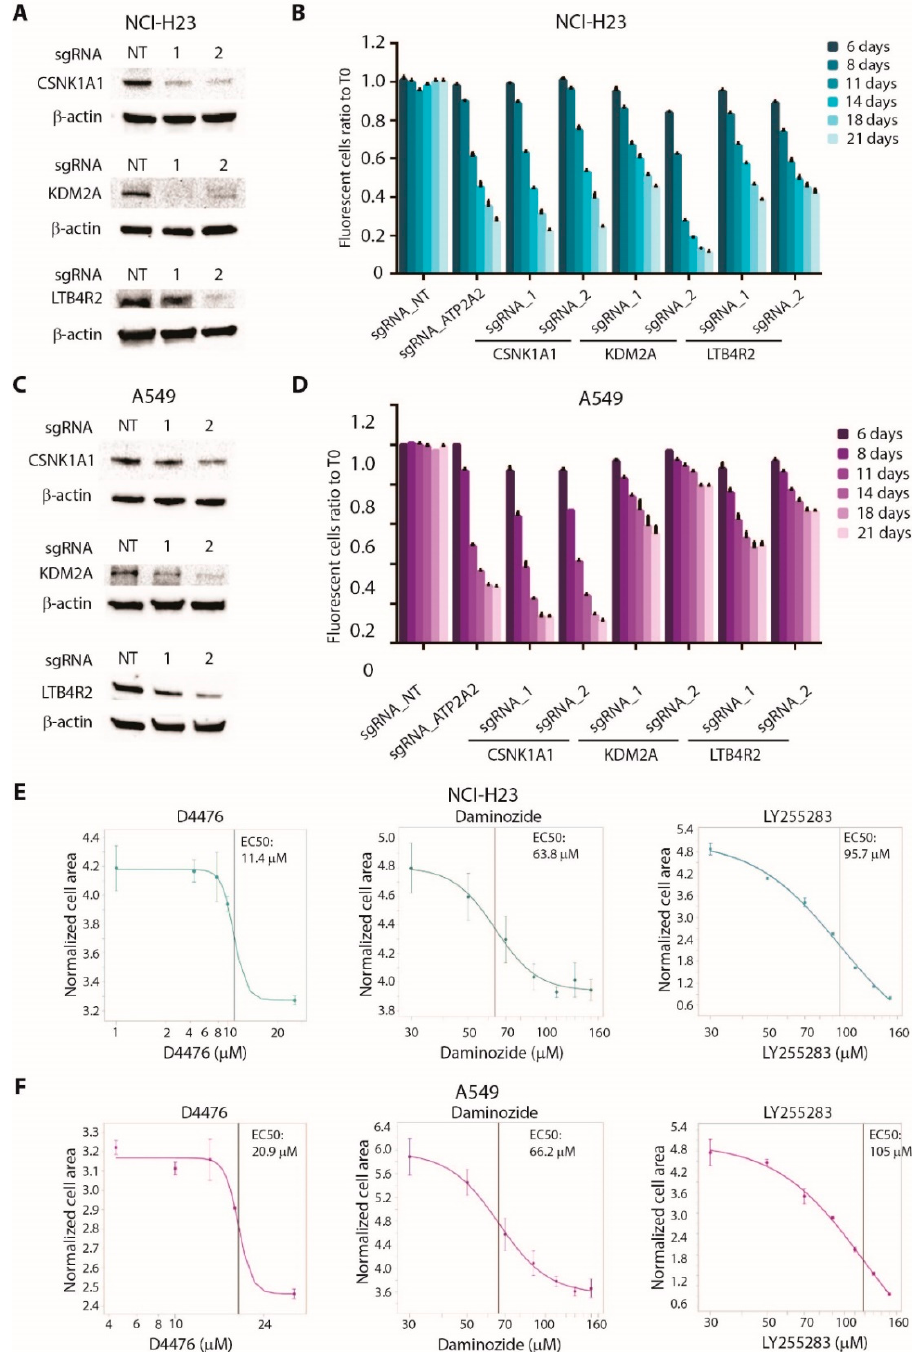
Figure 6. Validation of CSNK1A1, KDM2A, and LTB4R2 as new therapeutic target in lung cancer cell lines: ( A ) Western blot analysis showing CRISPR/Cas9-mediated knockout (KO) of CSNK1A1, KDM2A or LTB4R2 in NCI-H23 cells. Two independent sgRNAs for each gene were used. Anti- β -actin antibodies are used as loading control. ( B ) Competition